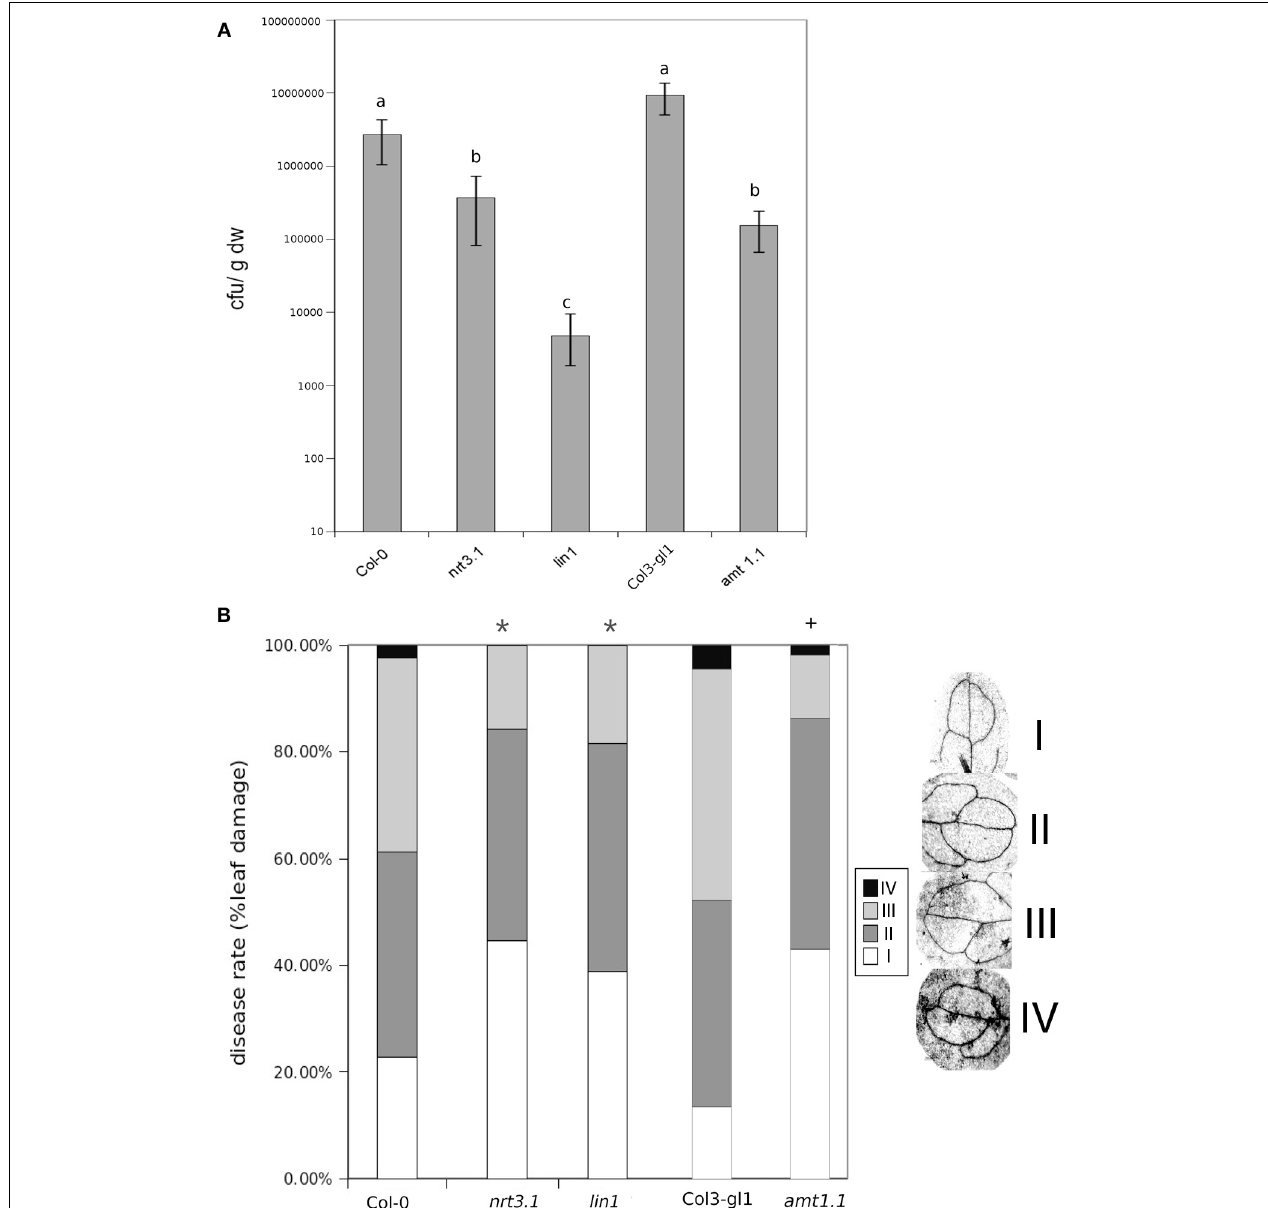
FIGURE 1 | Bacterial proliferation and disease rate in Col-0, lin1 , nrt3.1 , and Col3-gl/1 and amt1.1 plants infected with P. syringae and P. cucumerina respectivelly. (A) Five week old plants were challenge-inoculated by dipping in a bacterial suspension of P. syringae at 2 × 10 5 c.f.u. mL − 1 . The values presented are means ( ± SD) of the log of the proliferation values. Data represent the average of three independent experiments ( n = 3). Different letters mean significant statistical differences (ANOVA, LSD test; p < 0 . 05). (B) Two week old plants were inoculated by spraying with 1 × 10 3 spores × mL − 1 with PcBMM. Disease symptoms